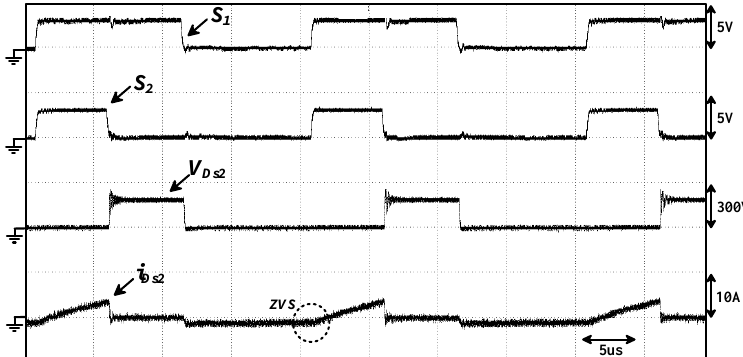
Figure 22. Experimental results for (top) switching control signals S 1 , S 2 and (bottom) corresponding voltage and current of switch S 2 during positive half line cycle.